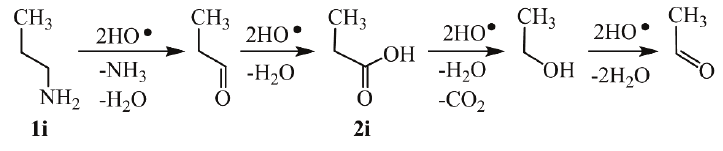
photocatalytic 2